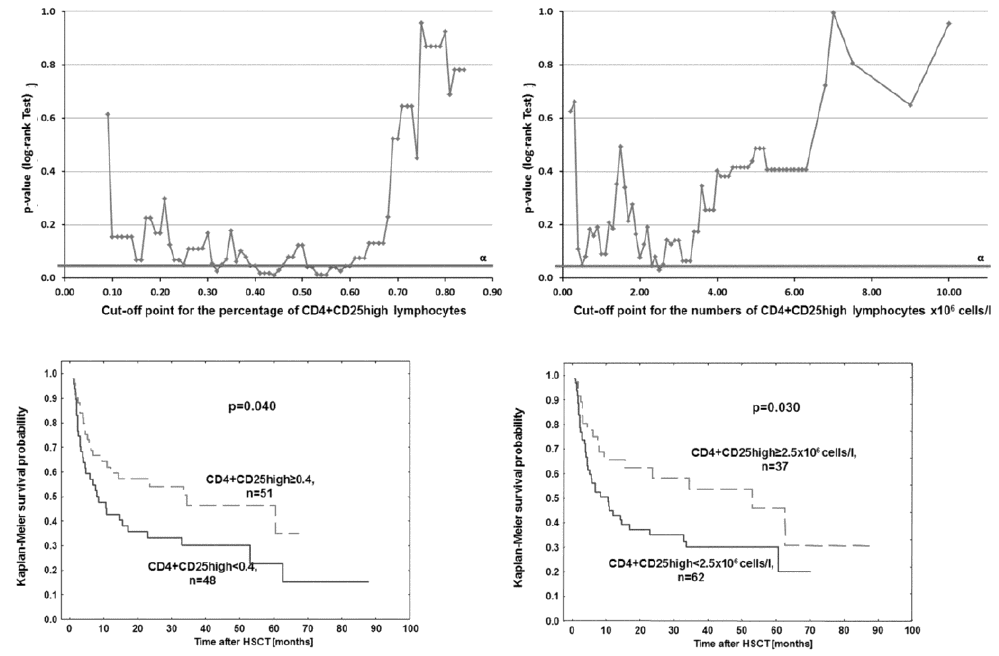
Figure 4. Overall survival of patients with higher and lower proportions and numbers (<0.4% and <2.5 × 106 cells/L, or the discriminative values for proportions and